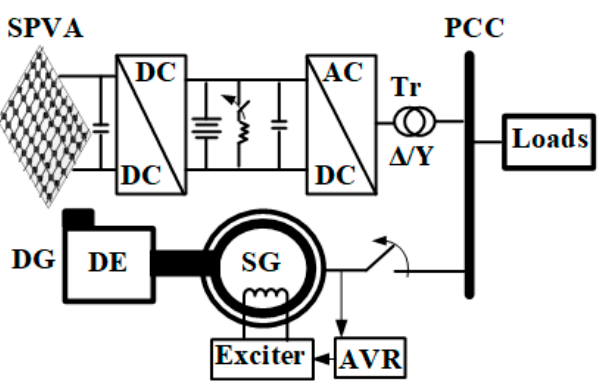
Figure 15. O ff grid-configuration based on SPVA and DG. Figure 15. Off grid-configuration based on SPVA and DG.